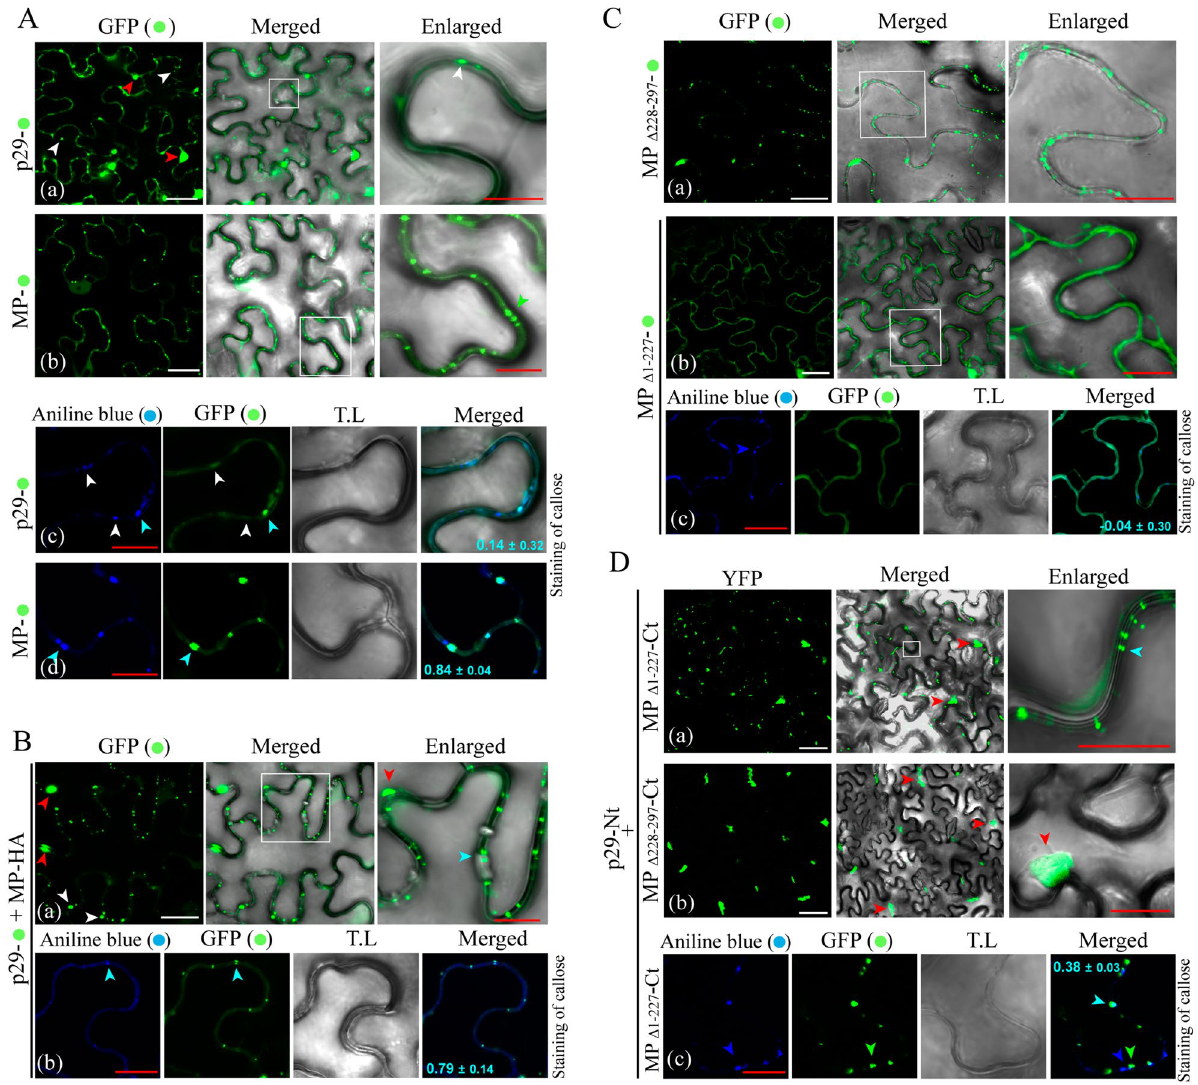
Figure 6. Redistribution of the coat protein (p29) from the cytoplasm to callose deposits in plasmodesma by interaction with the MP of CiLV-C. ( A ) Subcellular localization of the CiLV-C p29 and MP fused with eGFP (green filled circle) transiently expressed in N. benthamiana leaves visualized at 72 h post-infiltration. White boxes correspond to high magnification to highlight callose deposits. White and red arrows indicate small punctate structures and large agglomerates of p29 (a). The green arrow in enlarged image in (b) indicates MP punctate structures along the cell membrane. (c,d) show the callose deposits stained with aniline blue (blue filled circle). White and blue arrows indicate regions of callose deposition at the cell membrane and the co-localization among the callose deposits in plasmodesma with the p29 or MP proteins, respectively. ( B ) Expression assay to determine the re-co-localization of the p29 when co-expressed with the MP. The p29-eGFP was co-expressed with the MP-HA (a). Red and white arrows indicate p29 large and small structure, respectively. The callose staining (b) shows the co-localization between the p29 with callose deposits in plasmodesmata (blue arrow). ( C ) Sub-cellular localization of the mutated MP CiLV-C MPΔ 228–297 (a) lacking the C-terminus, and the remaining N-terminal region (CiLV-C MPΔ 1–227 ) (b), also stained with aniline blue fluorochrome (c). ( D ) BiFC analysis to determine the MP region responsible for redirecting the coat protein. The C- and N-fragment of MP (a/c,b, respectively) fused at their C-terminus with CYFP were co-expressed with the cognate p29 protein fused at its C-terminus with the NYFP counterpart. Red and blue arrows indicate agglomerates dispersed throughout the cytoplasm and punctate structures along cell periphery, respectively. In panel c, the dark blue and green arrows indicate the callose deposits and MP, respectively; while the light blue arrow indicates co-localization between them. The mean SD of PCC is given in the merged image that shows callose staining. The BiFC fluorescence was visualized at four days pot-infiltration. The blue (aniline blue), the green (GFP), transmitted light (T.L) channels and merge images are shown in the figure. White and red bars correspond to 50 and 10 μm,